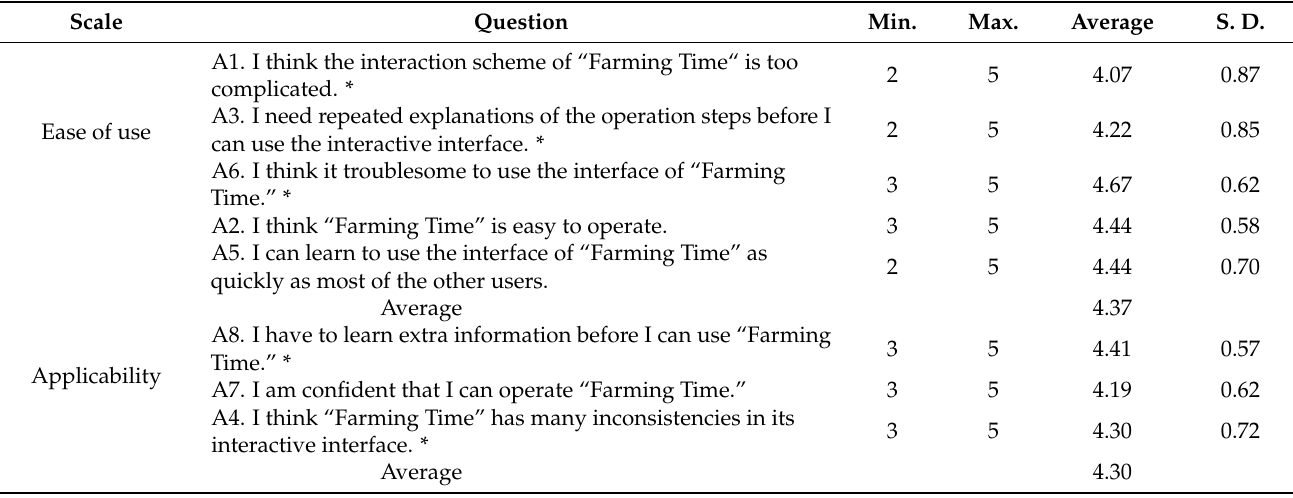
Table A5. Statistics of the Likert scores of the users’ answers of the questionnaire survey for the aspect of system usability (S.D.: standard